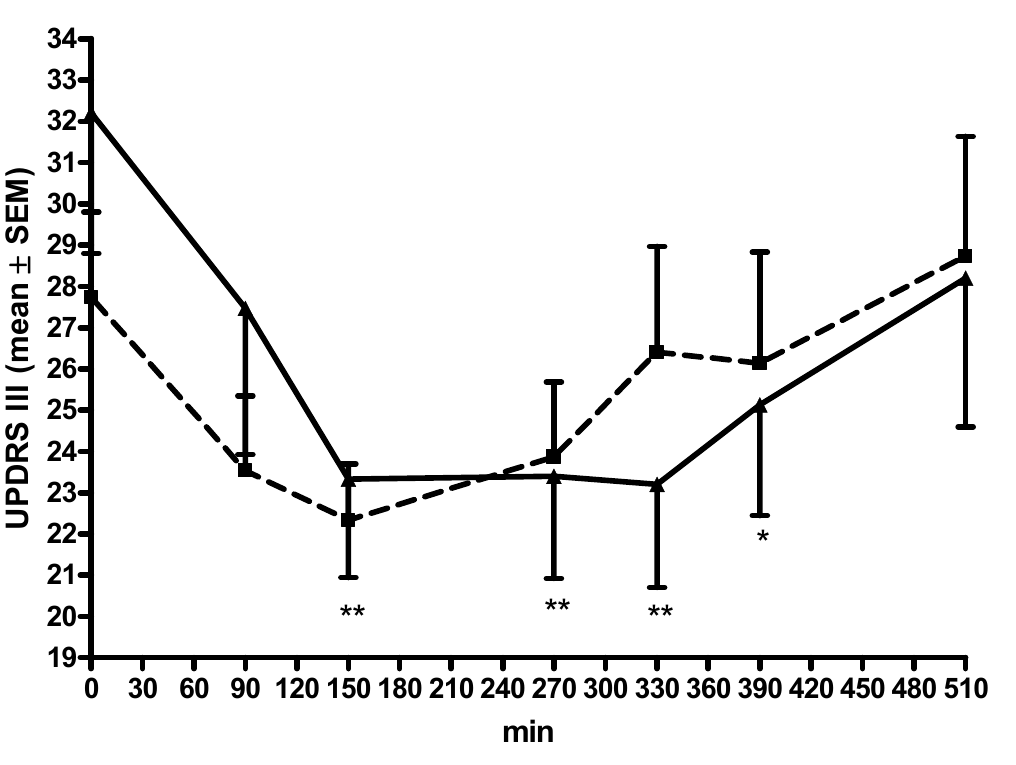
Figure 4. Scoring outcomes over the interval. All data are given as mean ± standard error of means (SEM); min, minutes; UPDRS III, Unified Parkinson’s Disease Rating Scale for motor examination; lines of the L-dopa/carbidopa plus opicapone condition are dashed with (cid:4) ; lines of the L-dopa/carbidopa/entacapone condition are continuous with (cid:78) ; comparisons of the post hoc analysis: * p < 0.05, ** p < 0.01; * reports comparisons against moment 0; error bars are above the curve of the L-dopa/carbidopa plus opicapone condition; error bars are below the curve of the L-dopa/carbidopa/entacapone condition.